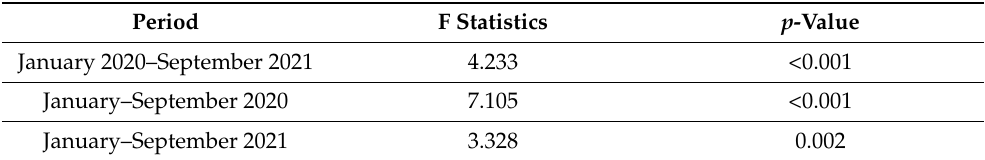
Table 5. Results of one-factor analysis of